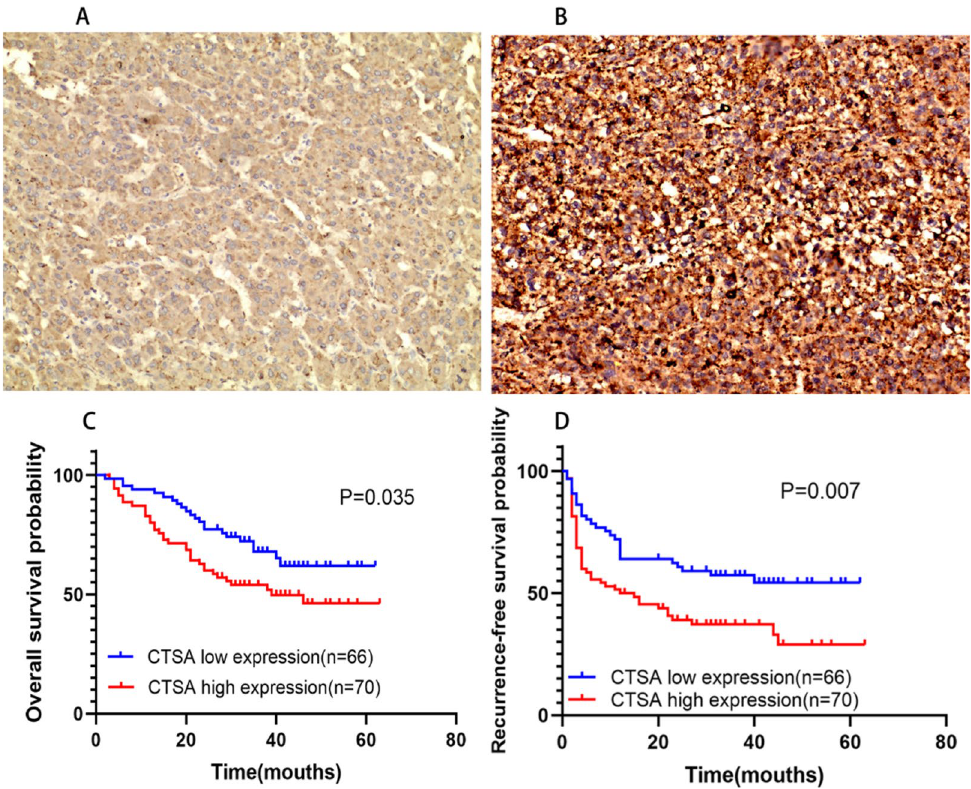
Figure 3. Analysis of CTSA expression and prognostic value of 136 cases of HCC patients. ( A , B ) Representative image of CTSA low ( A )/high ( B ) expression in tumor tissue from patients with HCC (× 200 magnification). ( C , D ) Kaplan–Meier curves of overall survival (OS) and recurrence-free survival (RFS) among different CTSA expression among 136 cases of HCC patients. High CTSA expression associated with poor OS ( G , P = 0.0035) and RFS ( H , P =